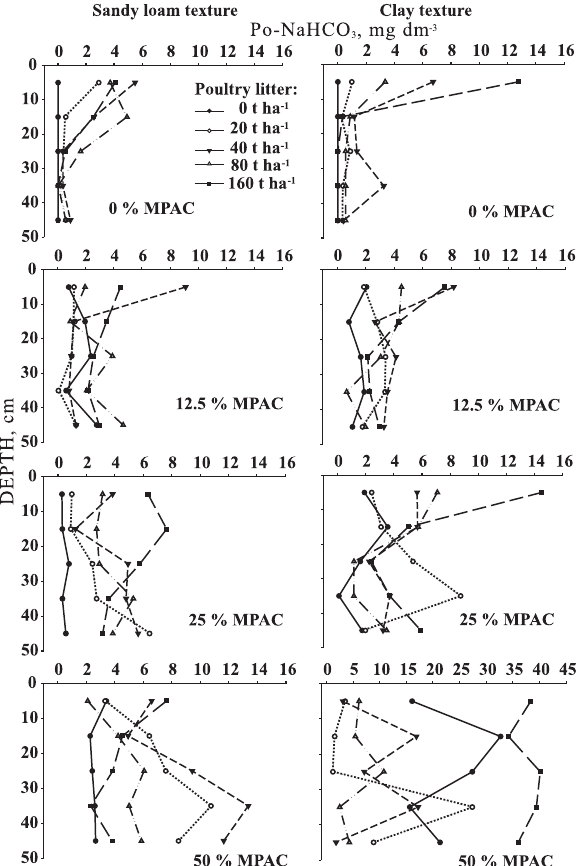
Figure 5. Organic phosphorus contents (Po) extracted by NaHCO (Po-NaHCO ) from 3 3 samples of two Latosols with sandy loam und clay texture, prefertilized with increasing mineral P rates as related to the poultry litter rates applied in the top